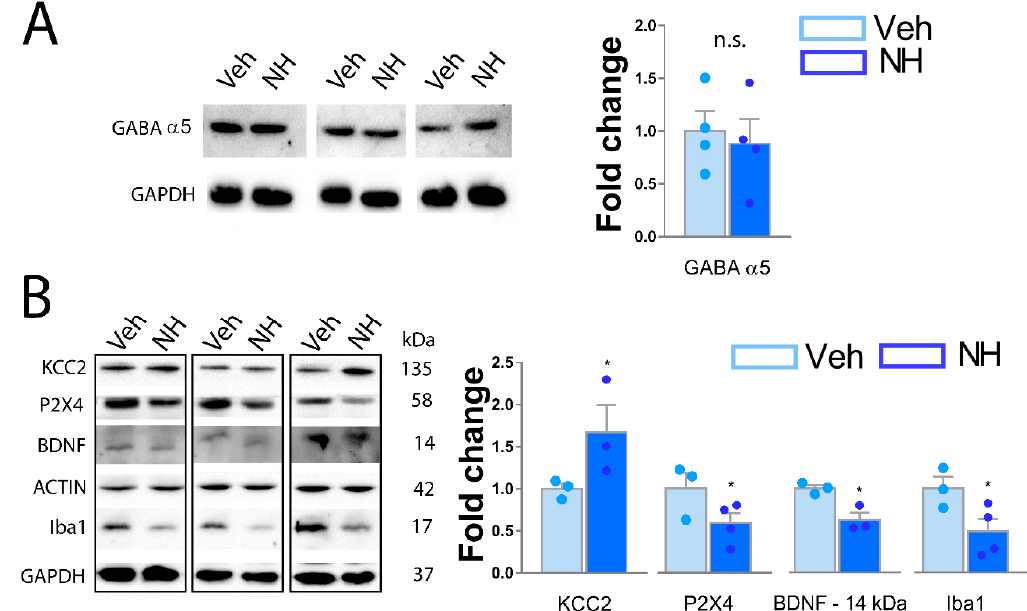
Figure 6 . Modulation of P2X4-BDNF-KCC2-Iba1 axis by NeuroHeal. ( A ) Western blot and corresponding bar graph of the quantification α 5 GABA subunit in the dorsal horn from L4-L5 spinal cords from Vehicle (NH) or NeuroHeal (NH) treated SNI animals. ( n = 4 biological replicates, t -test, * p < 0.05 vs. Veh; n.s. = nonsignificant). ( B ) Western blot and corresponding bar graph of the quantification of P2X4, BDNF (14kDa), KCC2 monomer, and Iba1 subunit in the dorsal horn from L4-L5 spinal cords from Vehicle (Veh) or NeuroHeal (NH) treated SNI animals. ( n = 3–4 biological replicates, t -test, post hoc Bonferroni, * p ≤ 0.05 vs. Veh).